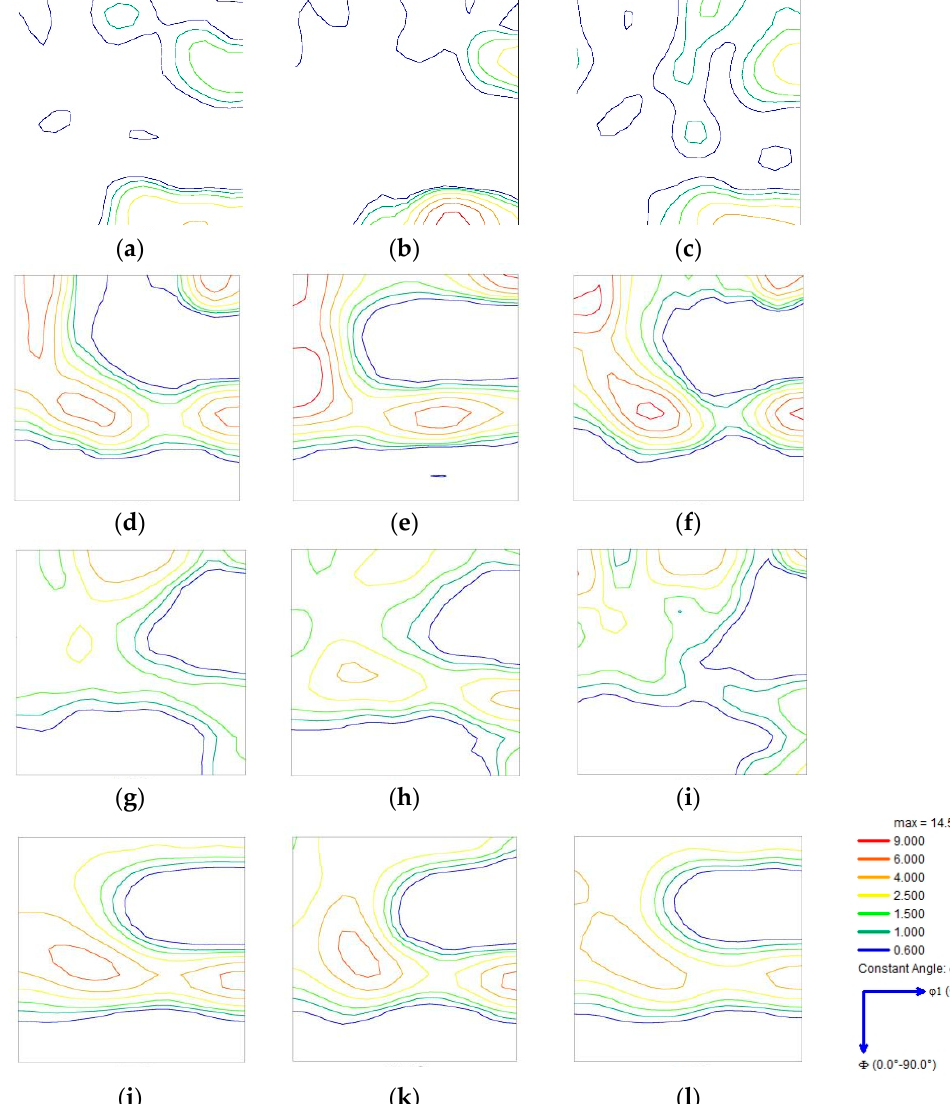
Figure 4. ODFs at φ 2 = 45°section of surface texture at different slab temperatures: ( a ) 1170 °C, hot rolling, ( b ) 1220 °C, hot Figure 4. ODFs at ϕ 2 = 45 ◦ section of surface texture at different slab temperatures: ( a ) 1170 ◦ C, hot rolling, ( b ) 1220 ◦ C, rolling, ( c ) 1270 °C, hot rolling, ( d ) 1170 °C, the first cold rolling, ( e ) 1220 °C, the first cold rolling, ( f ) 1270 °C, the first cold hot rolling, ( c ) 1270 ◦ C, hot rolling, ( d ) 1170 ◦ C, the first cold rolling, ( e ) 1220 ◦ C, the first cold rolling, ( f ) 1270 ◦ C, the first rolling, ( g ) 1170 °C, intermediate annealing, ( h ) 1220 °C, intermediate annealing, ( i ) 1270 °C, intermediate annealing, ( j ) cold rolling, ( g ) 1170 ◦ C, intermediate annealing, ( h ) 1220 ◦ C, intermediate annealing, ( i ) 1270 ◦ C, intermediate annealing, 1170 °C, the second cold rolling, ( k ) 1220 °C, the second cold rolling, ( l ) 1270 °C, the second cold rolling. ( j ) 1170 ◦ C, the second cold rolling, ( k ) 1220 ◦ C, the second cold rolling, ( l ) 1270 ◦ C, the second cold